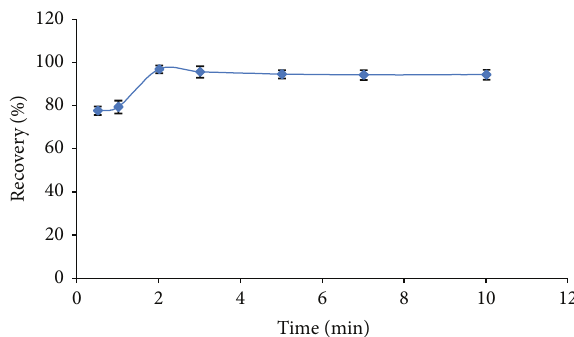
Figure 10: Effect of eluent volume on the recovery of CV. Con- ditions: pH: 9, amount of CV: 50 𝜇 gL −1 , sample volume: 25 mL,